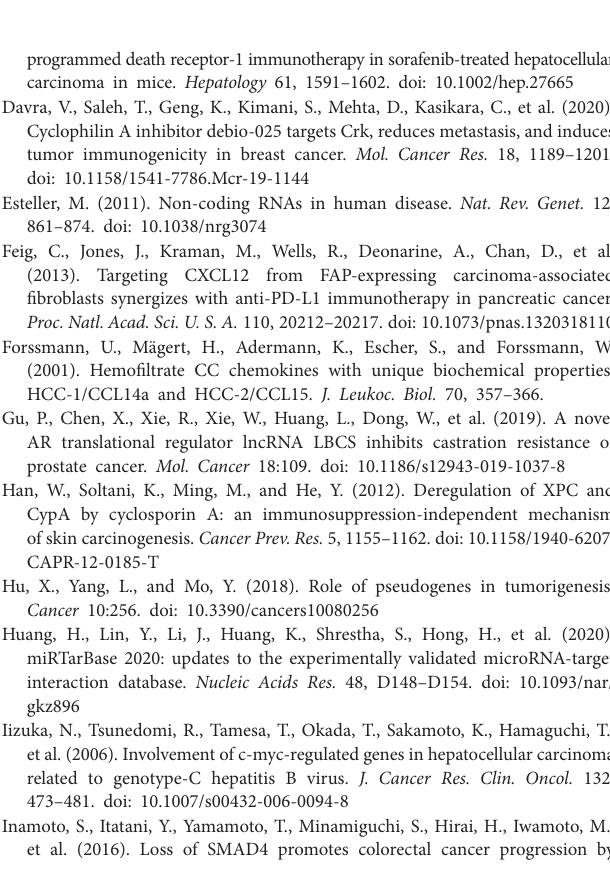
Supplementary Figure S1 | The correlation between expression of PPIAP22 and clinicopathologic features. Supplementary Figure S2 | The correlation between expression of PPIA and clinicopathologic